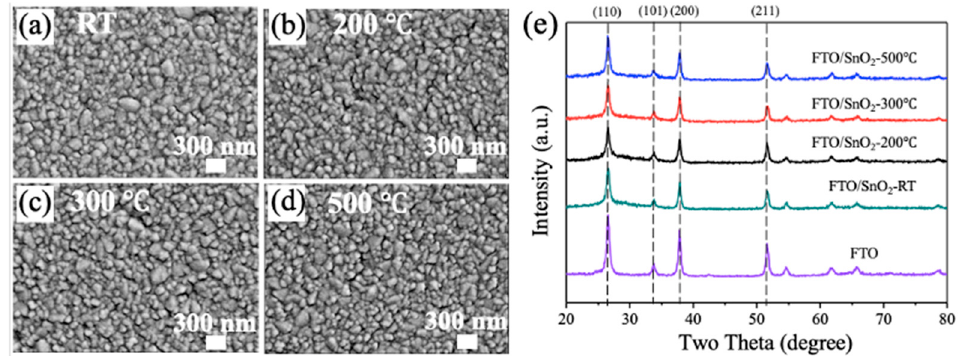
Figure 1. Surface morphologies of FTO/SnO 2 thin films ( a ) at RT and annealed at ( b ) 200 ◦ C ( c ) 300 ◦ C ( d ) 500 ◦ C by field emission scanning electron microscope. ( e ) X-ray diffraction patterns of FTO and FTO/SnO 2 thin films annealed at various temperatures. RT stands for room temperature.